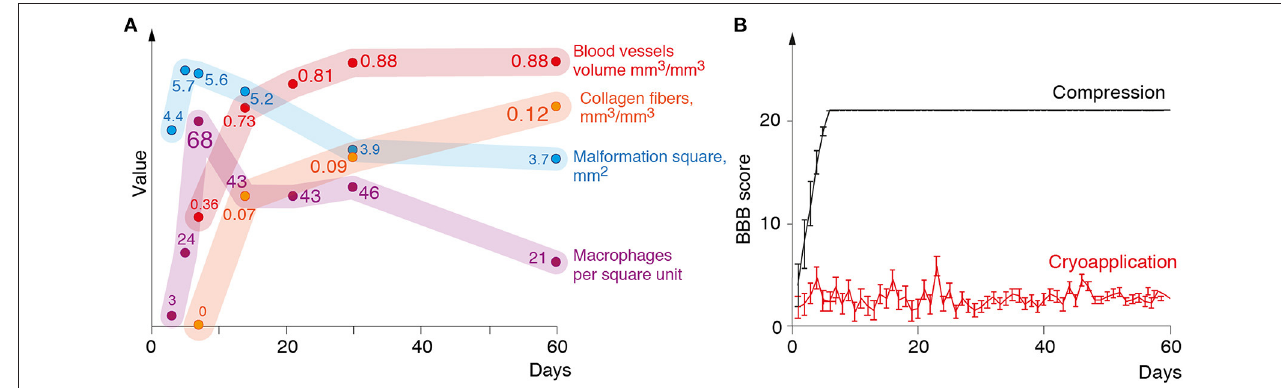
FIGURE 2 | (A) Changes in the lesion size, the number of macrophages, volume of blood vessels, and connective tissue in the lesion during 60 days following the cryoinjury. (B) Mean BBB (Y-axis) score of the rats over a 2-month observation period (X-axis).